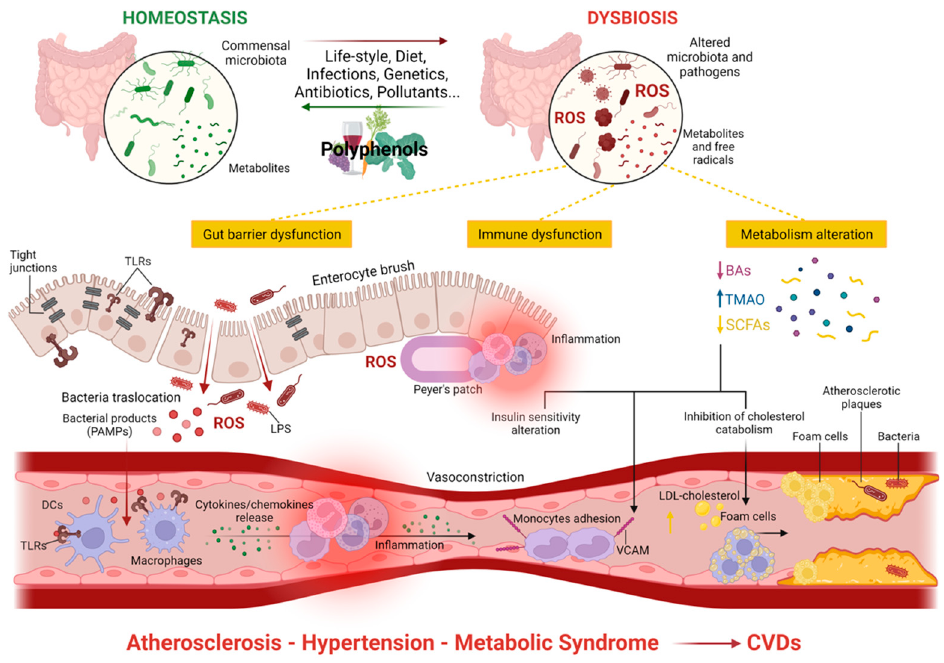
Figure 2. The role of gut microbiota alterations in the main mechanisms associated with risk factors for CVDs.